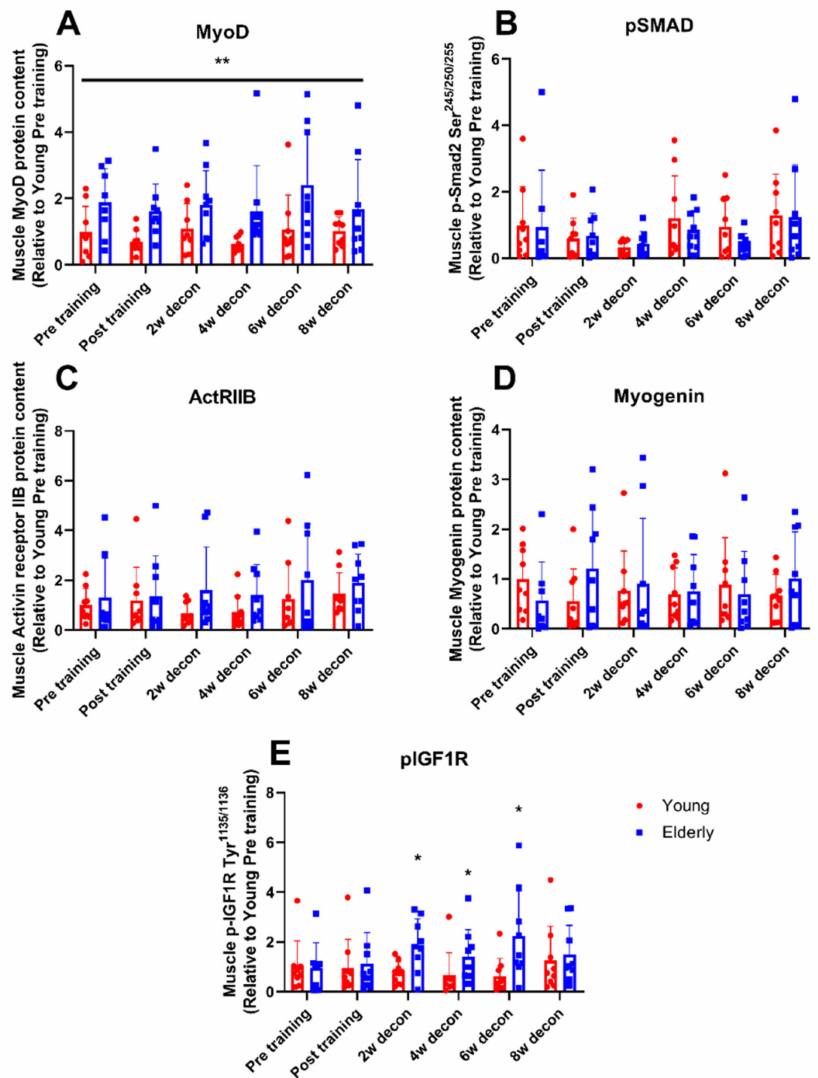
Figure 3. Muscle regulatory factors. Muscle regulatory factors measured in skeletal muscle pre and post six weeks of resistance exercise training and during 2, 4, 6, and 8 weeks into a subsequent deconditioning period in young (red bars) and elderly (blue bars) individuals. ( A ) Protein expression of activin receptor IIB, ( B ). Phosphorylation level of smad2 at Ser245 / 250 / 255. ( C ) Protein expression of MyoD. ( D ) Protein expression of myogenin. ( E ) Phosphorylation level of IGF-I-R at Tyr1135 / 1136. Measurements have been performed as single determinations by Western blotting. Representative Western blots are shown in Supplementary Figure S1. n = 9 in young group and n = 9 in the elderly group. Values are arbitrary units (means ± SD) and expressed relative to young group pre training. * p < 0.05, young vs. elderly group, ** p < 0.01, main e ff ect of age independently of training and deconditioning. ANOVA F-values (F time / F age / F time × age ): ( A ) 1.08 / 11.62 / 0.32; ( B ) 0.76 / 0.58 / 0.49; ( C ) 0.77 / 2.97 / 0.23; ( D ) 0.09 / 0.15 / 1.20; ( E ) 0.54 / 8.62 /